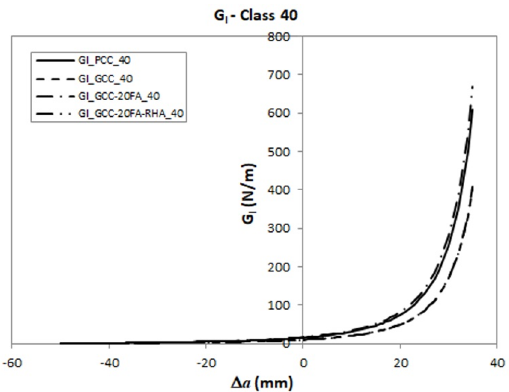
Figure 7. Variation of deformation energy release rate with the extension of the crack for concrete notched beams of strength class of 40 MPa with, different matrices.